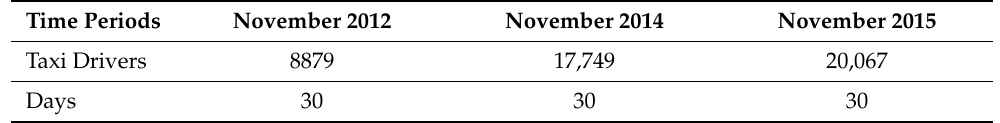
Table 5. Data summary for the GPS trajectory dataset contributed in this study.